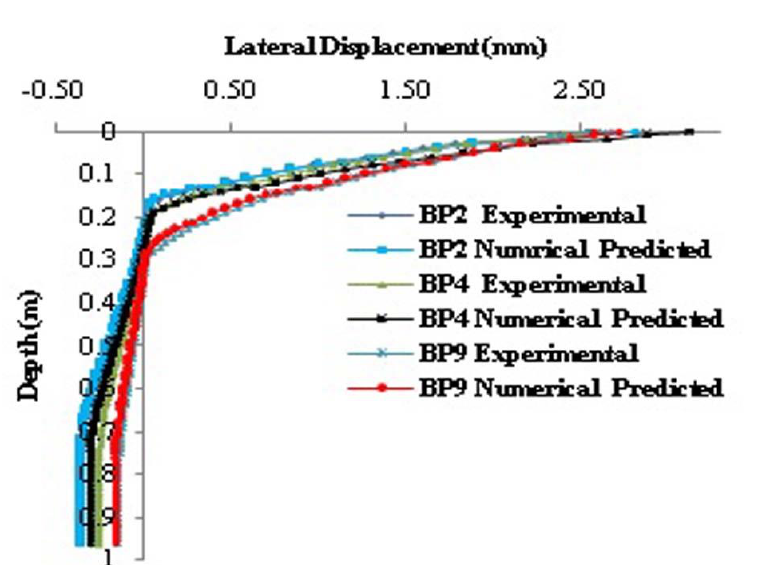
Fig. 12. Lateral displacements along the depth of bamboo pipe in pile group at 3D pile spacing in loose layer in-between dense layers for slenderness ratio as